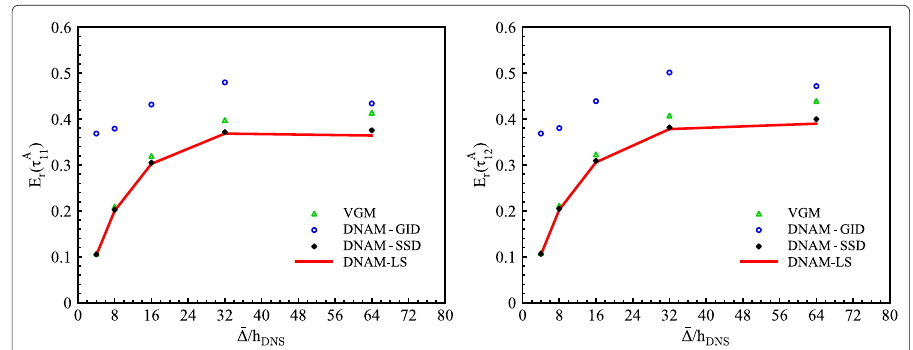
Fig. 3 Relative errors of normal and shear SGS stresses in the apriori